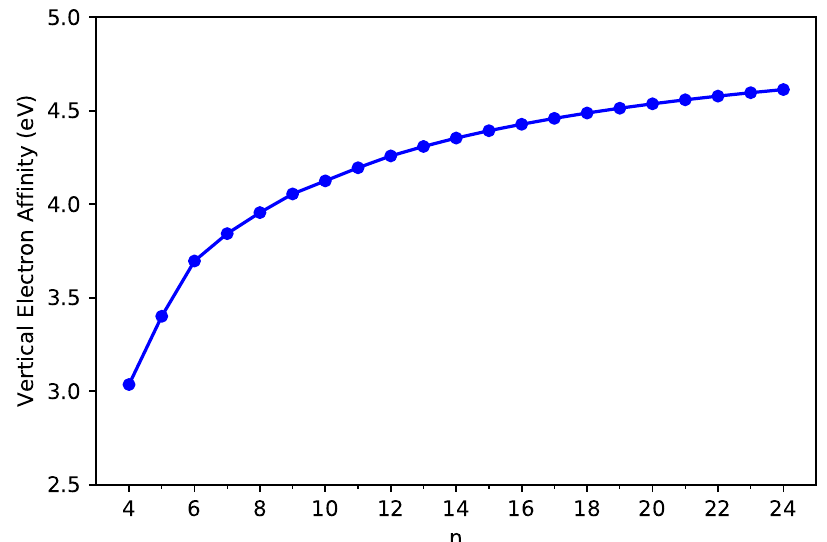
Figure 4. Vertical electron affinity of ground-state C-Belt[ n ], computed using spin-unrestricted TAO-LDA.